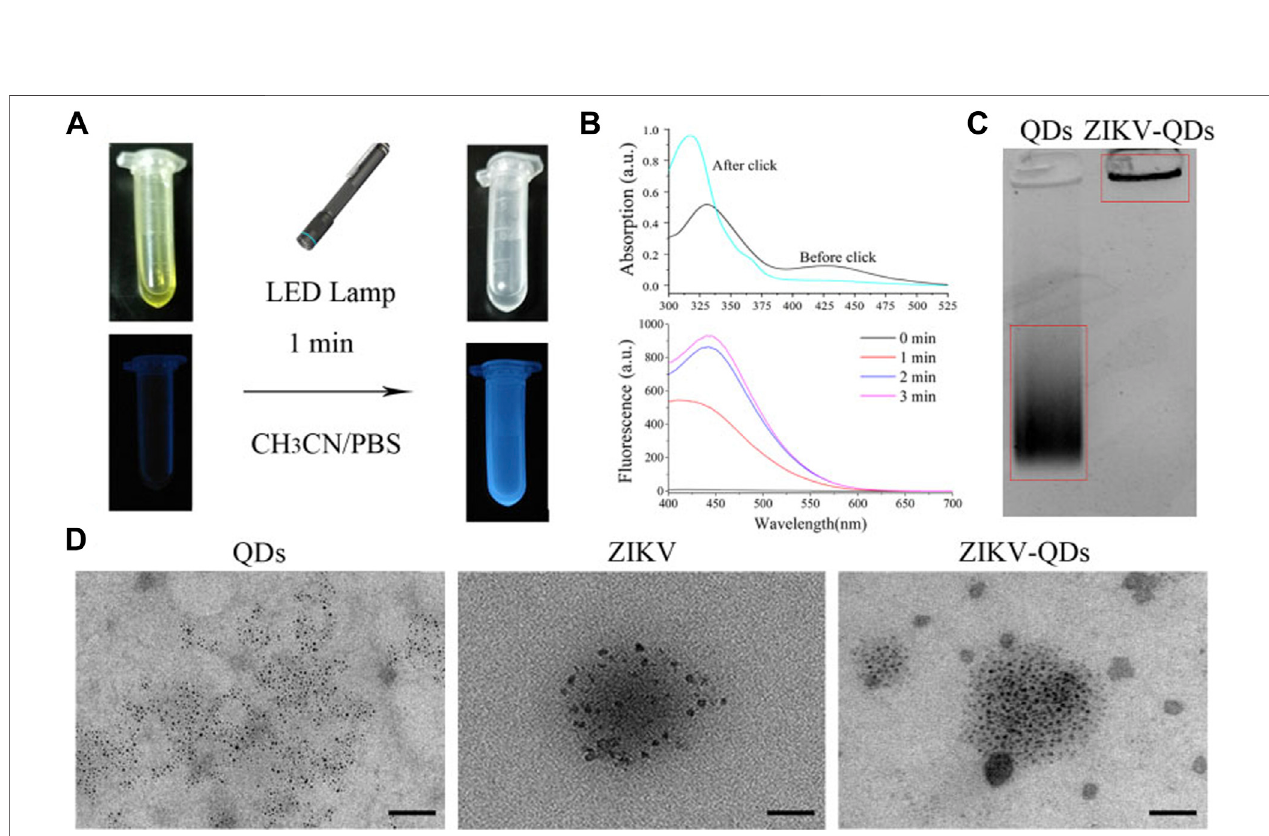
Frontiers in Bioengineering and Biotechnology |